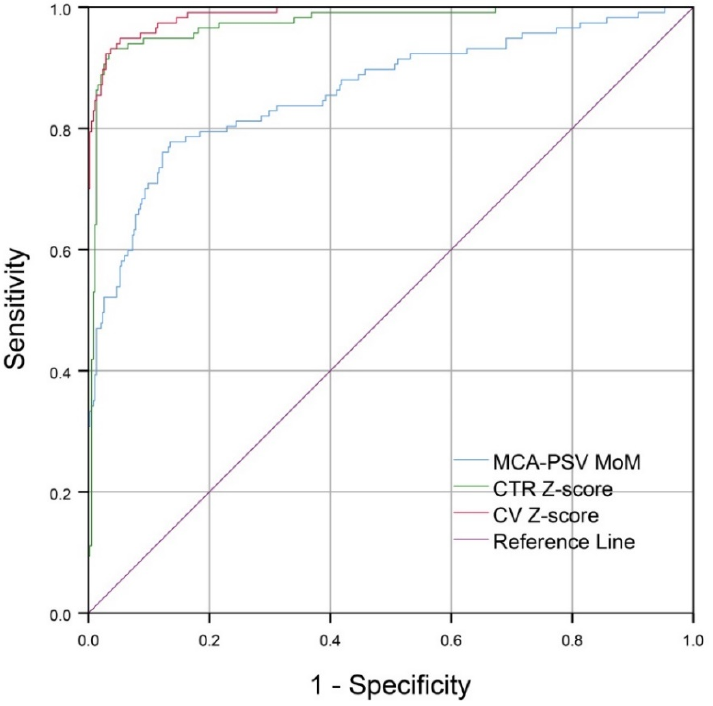
Figure 3. The ROC curves represent performances of CV Z-scores, CTR Z-scores and MCA-PSV MoMs in predicting the fetuses with Hb Bart’s disease. Table 2. Comparisons of the areas under ROC curve of CV Z-scores, CTR-Z-scores and MCA-PSV MoMs in predicting fetal Hb Bart’s disease.